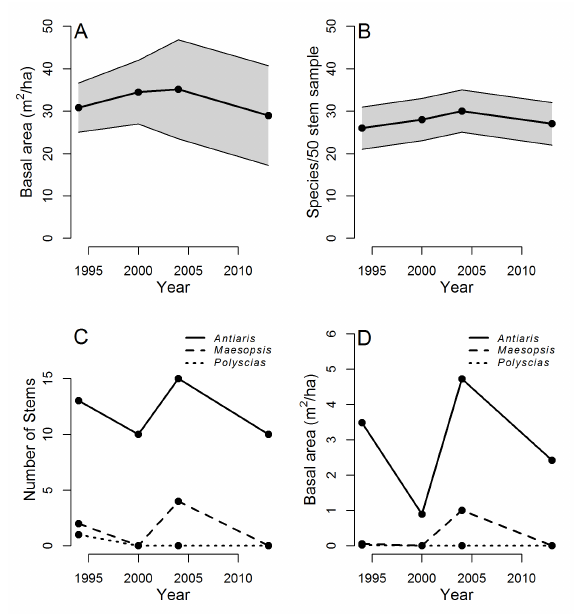
Fig. 1. Trends in measures of forest structure and biodiversity from plot-based measurements in Mpanga Central Forest Reserve near Mpigi, Uganda. Sampling effort was the same during both site visits: 30 circular plots each covering 0.0314 ha. Mean (line) and 95% confidence intervals (grey) for basal area of all trees ≥ 10 cm diameter at breast height (A) and tree species richness in a 50 stem sample (B). Number of stems sampled (C) and basal area (D) of three tree species used for drum making. No statistically significant differences were found among site visits for basal area (A) or tree richness (B). No statistical tests were performed for (C) and (D) because of small sample